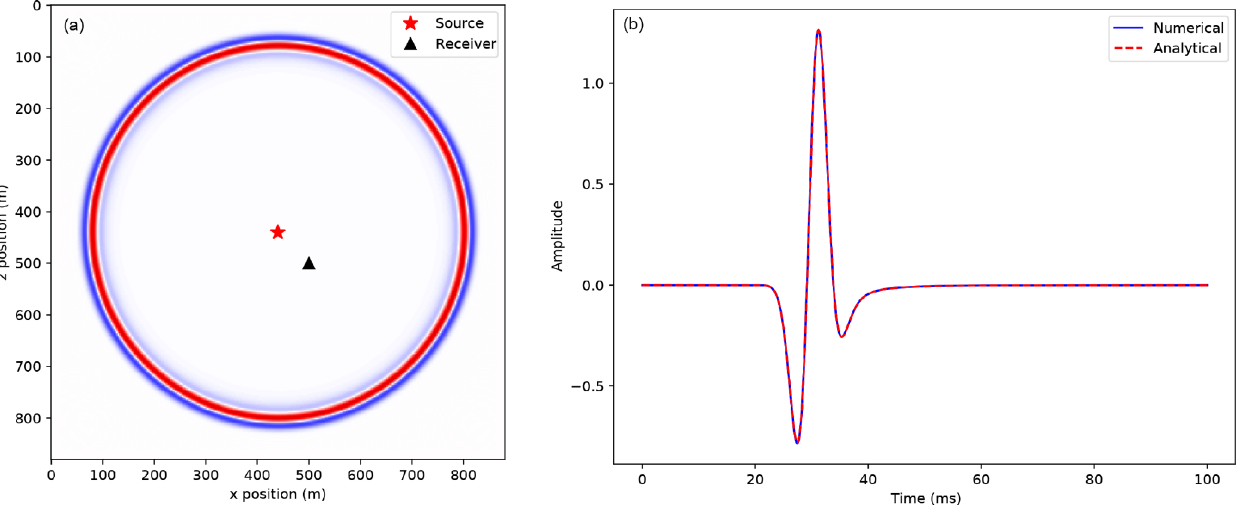
Figure 9. Numerical wave field for a constant velocity d t = 0 . 1ms, h = 1m and comparison with the analytical